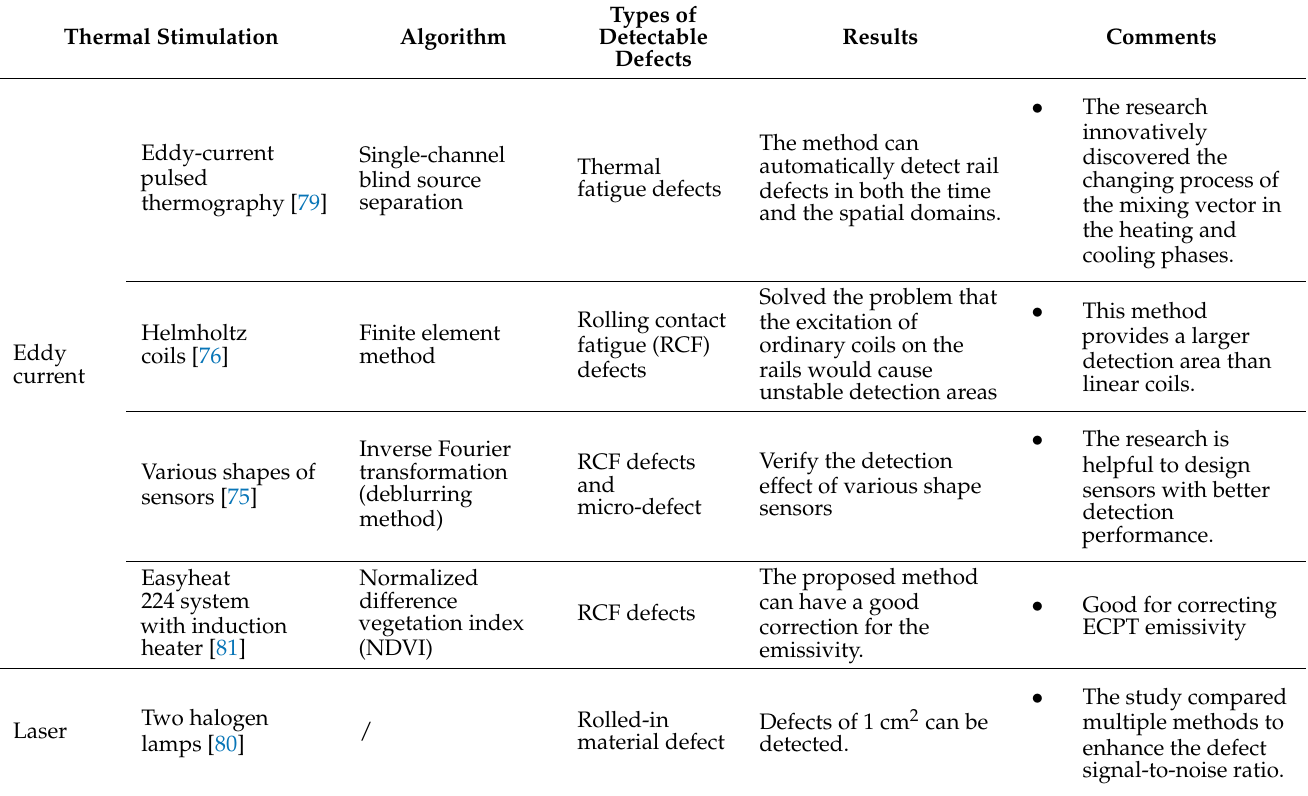
Table 5. Comparison of thermal imaging testing methods.